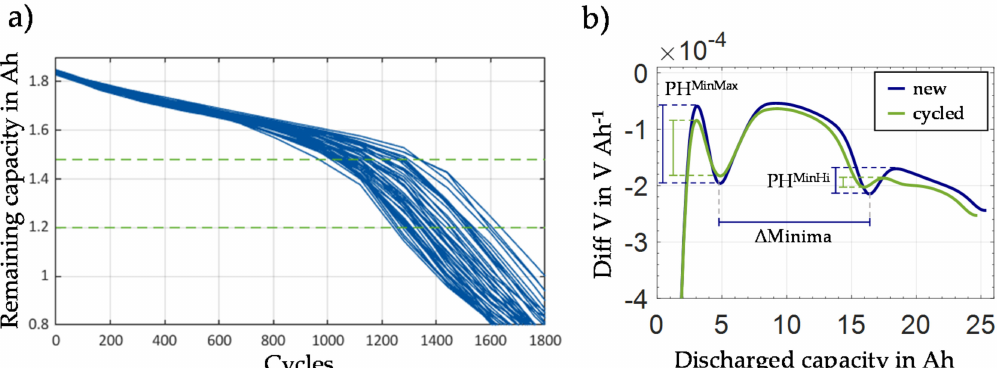
Figure 10. Different aging trends and differential voltage analysis: ( a ) The 48 cells under equal conditions with focus on inherent production caused cell-to-cell variance and capacity degradation over cycles, 80% and 60% of initial capacity are marked with green dashed line. Reproduced from Baumhöfer et al. [61]. ( b ) Differential voltage analysis on a 25 Ah cell to determine changes in the peak heights to quantify the homogeneity of lithium distribution